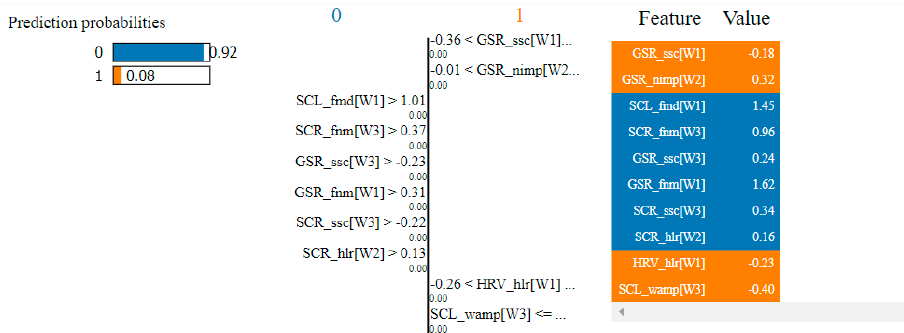
Figure 25. Prediction features for situation 0 (no fear), for the non-overlapping dataset.